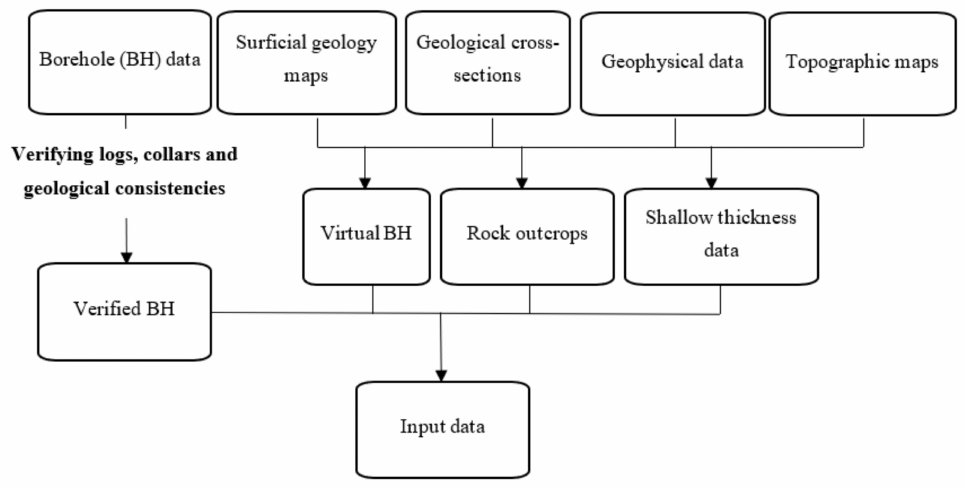
Figure 2. Phase I: workflow of data